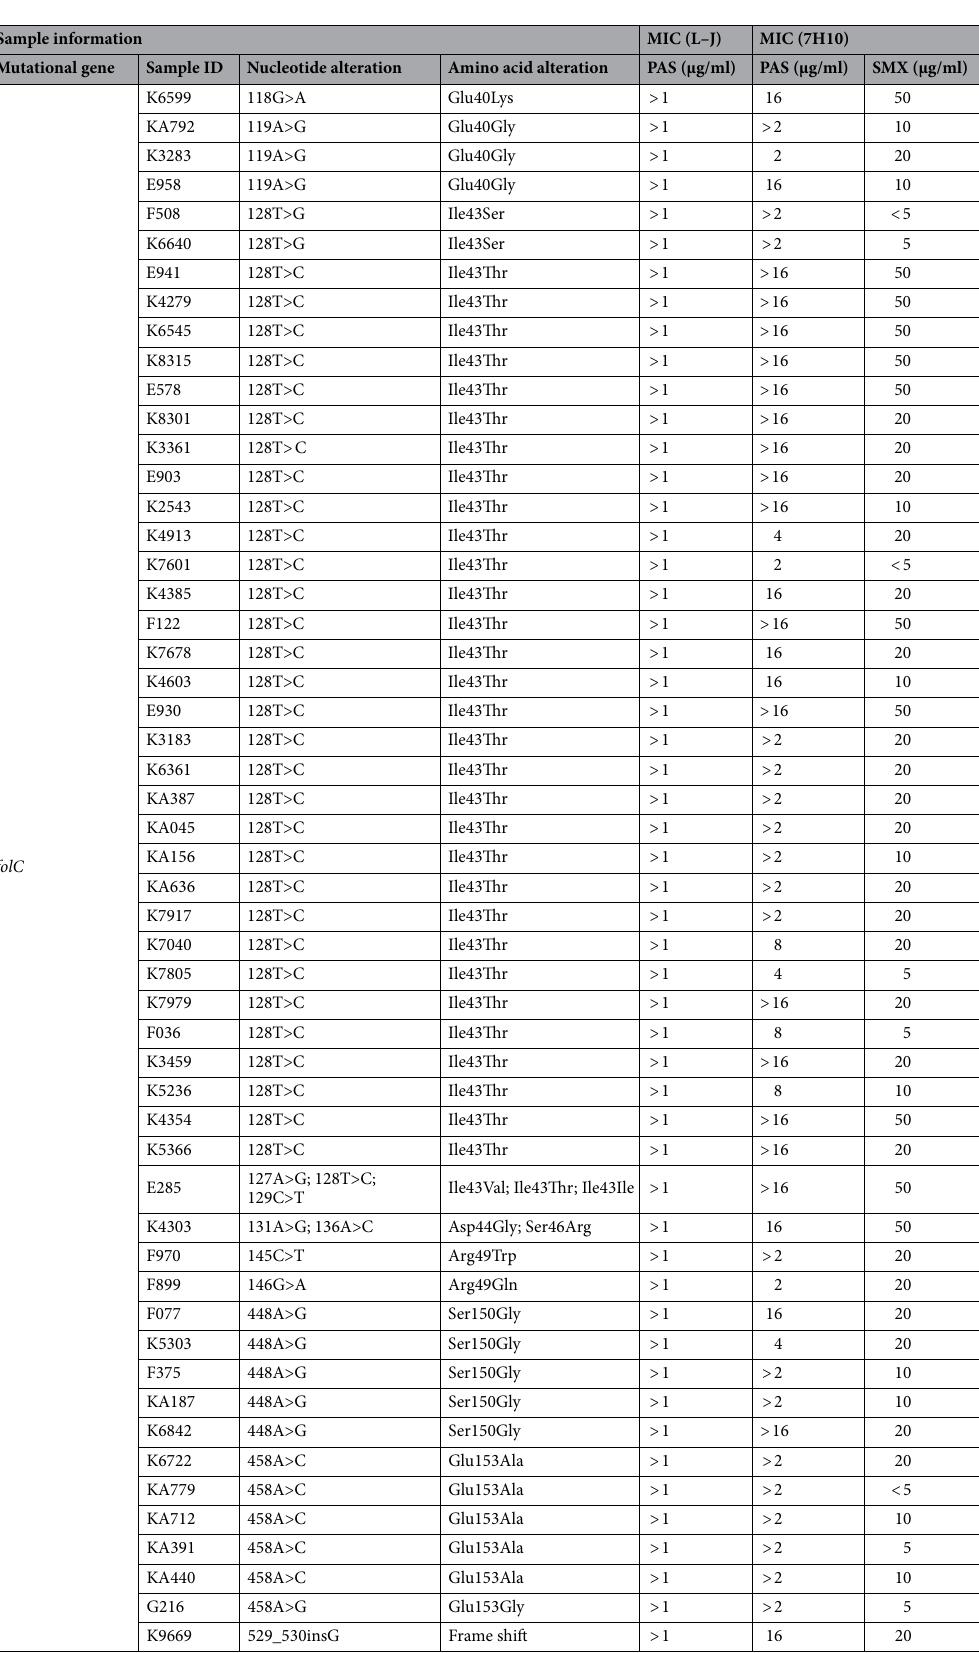
Table 3. Detailed information of mutations in thyA , ribD , and folC and PAS/SMX DST results of the 95 clinical isolates. ID identification, NO no mutations present, MIC minimal inhibitory